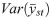

Var(y¯st) for y in simulated data.